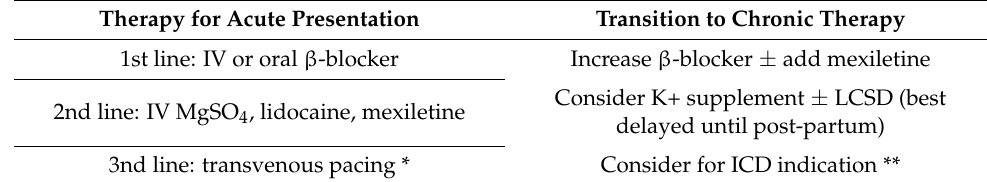
Table 2. Treatment of unstable cardiac rhythm disturbances of LQTS in pregnancy. Adapted from Roston et al.